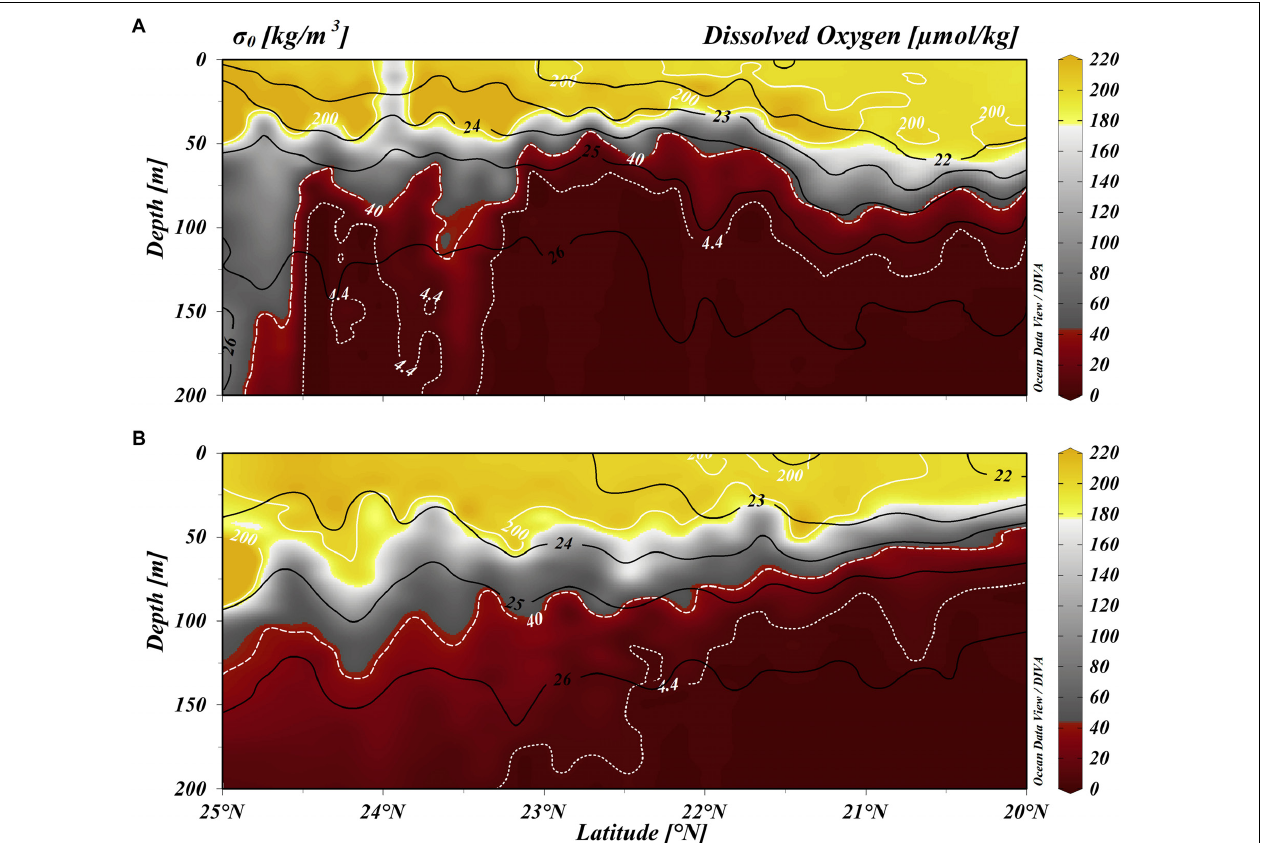
FIGURE 5 | Vertical distribution of dissolved oxygen (DO, µ mol/kg) and potential density anomaly ( σ 0 , kg/m 3 ) along transect 1 (see Figure 1 ). (A) June 2015, (B) March 2016. Refer to text for DO limits.